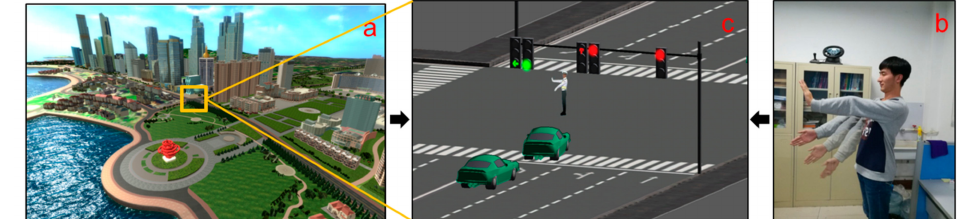
Figure 1. The virtual city traffic scene is constructed, and the intersection modeling is emphasized. ( a ) is a part of the virtual urban scene. The traffic police command gesture recognition system is set up to facilitate real-time human–computer interaction (HCI). Communication between the traffic scene and the identification system is achieved. A volunteer is making traffic police command gestures in the real environment in ( b ), which is mapped to the virtual scene in ( c